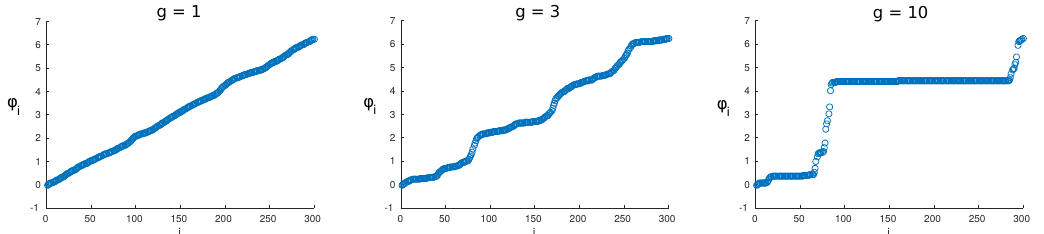
Figure 2 . Typical con(cid:12)gurations of the discretized (cid:30) varible that contribute to Z ( g ) for the discretized Schwarzian theory. The con(cid:12)gurations were generated using the Metropolis algorithm, with a lattice of n = 300. The (cid:12)gure at left contains only small (cid:13)uctuations about the saddle point, which would be a straight line (cid:30) j = 2 (cid:25)j n